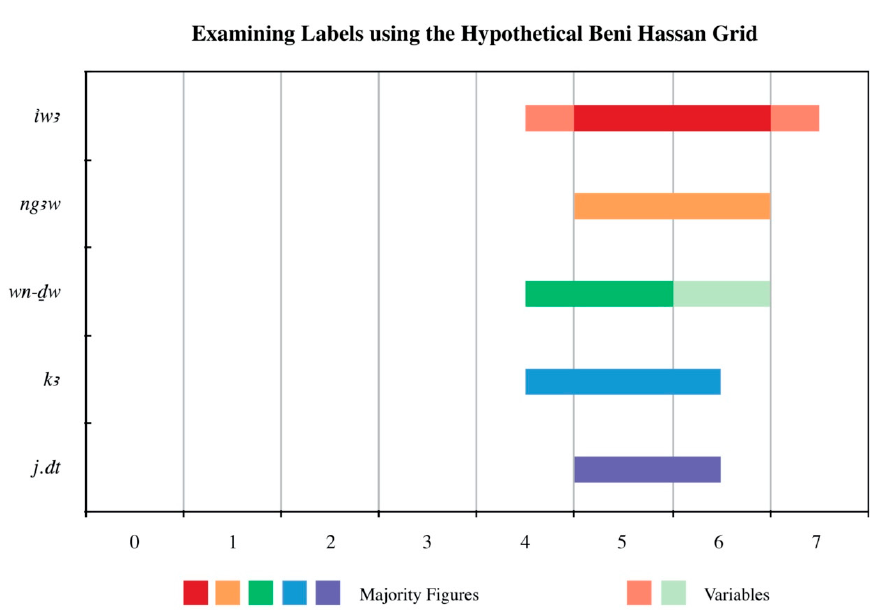
Figure 10. Examining ancient Egyptian labels using the hypothetical Beni Hassan grid.